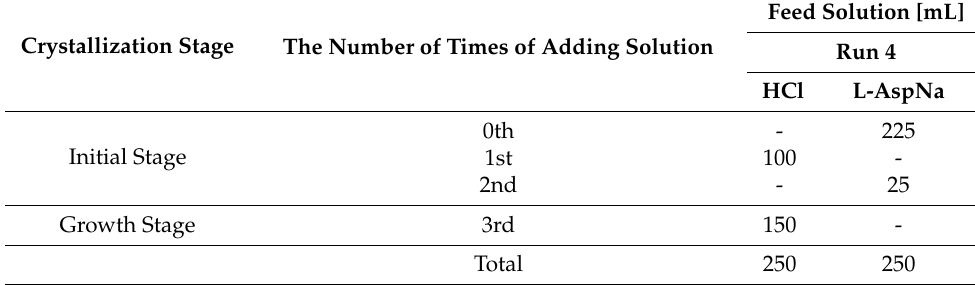
Table 2. The detailed addition methods in Run 4.